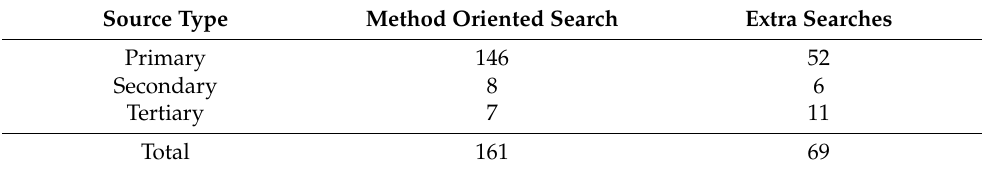
Table 1. Primary, secondary and tertiary sources found from literature and selected via